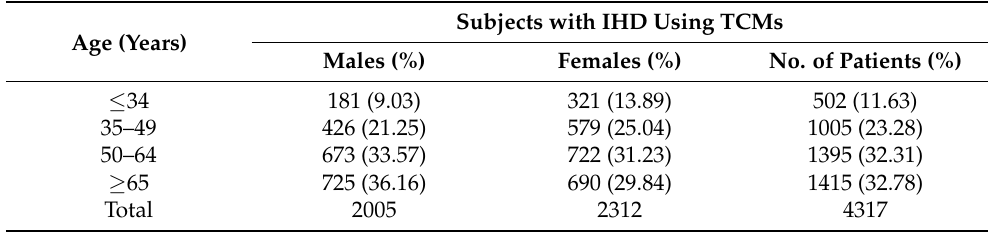
Table 1. Age-specific frequencies for the use of traditional Chinese medicines (TCMs) among patients with ischemic heart disease (IHD). Total subjects, n = 4317.